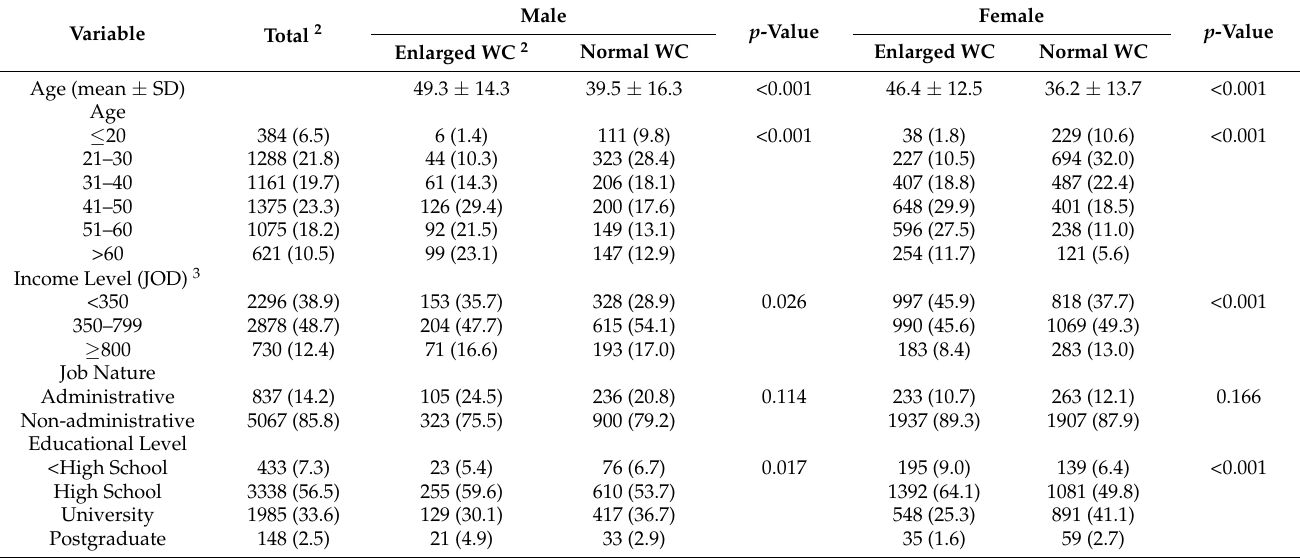
Table 2. Waist Circumference (WC) relation with population characteristics stratified by sex 1